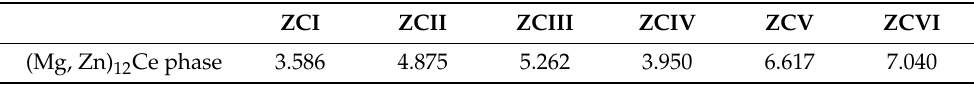
Table 3. The mass fraction of the (Mg, Zn) 12 Ce phase in the as-cast alloys.